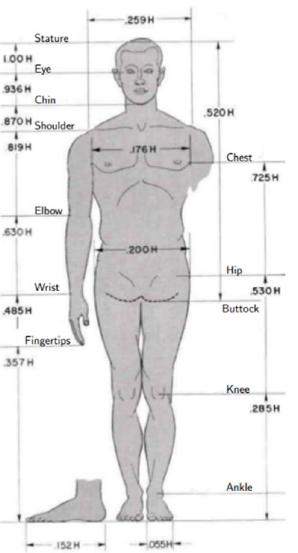
Fig. 4 Body segment lengths expressed as a percentage of height [30].